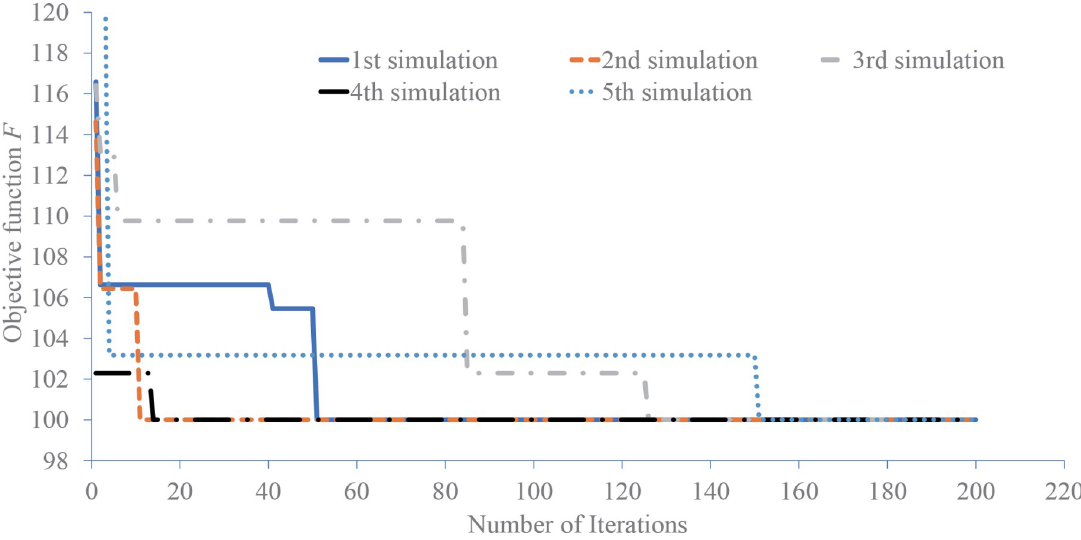
Fig 6. Comparison graph of objective function change.